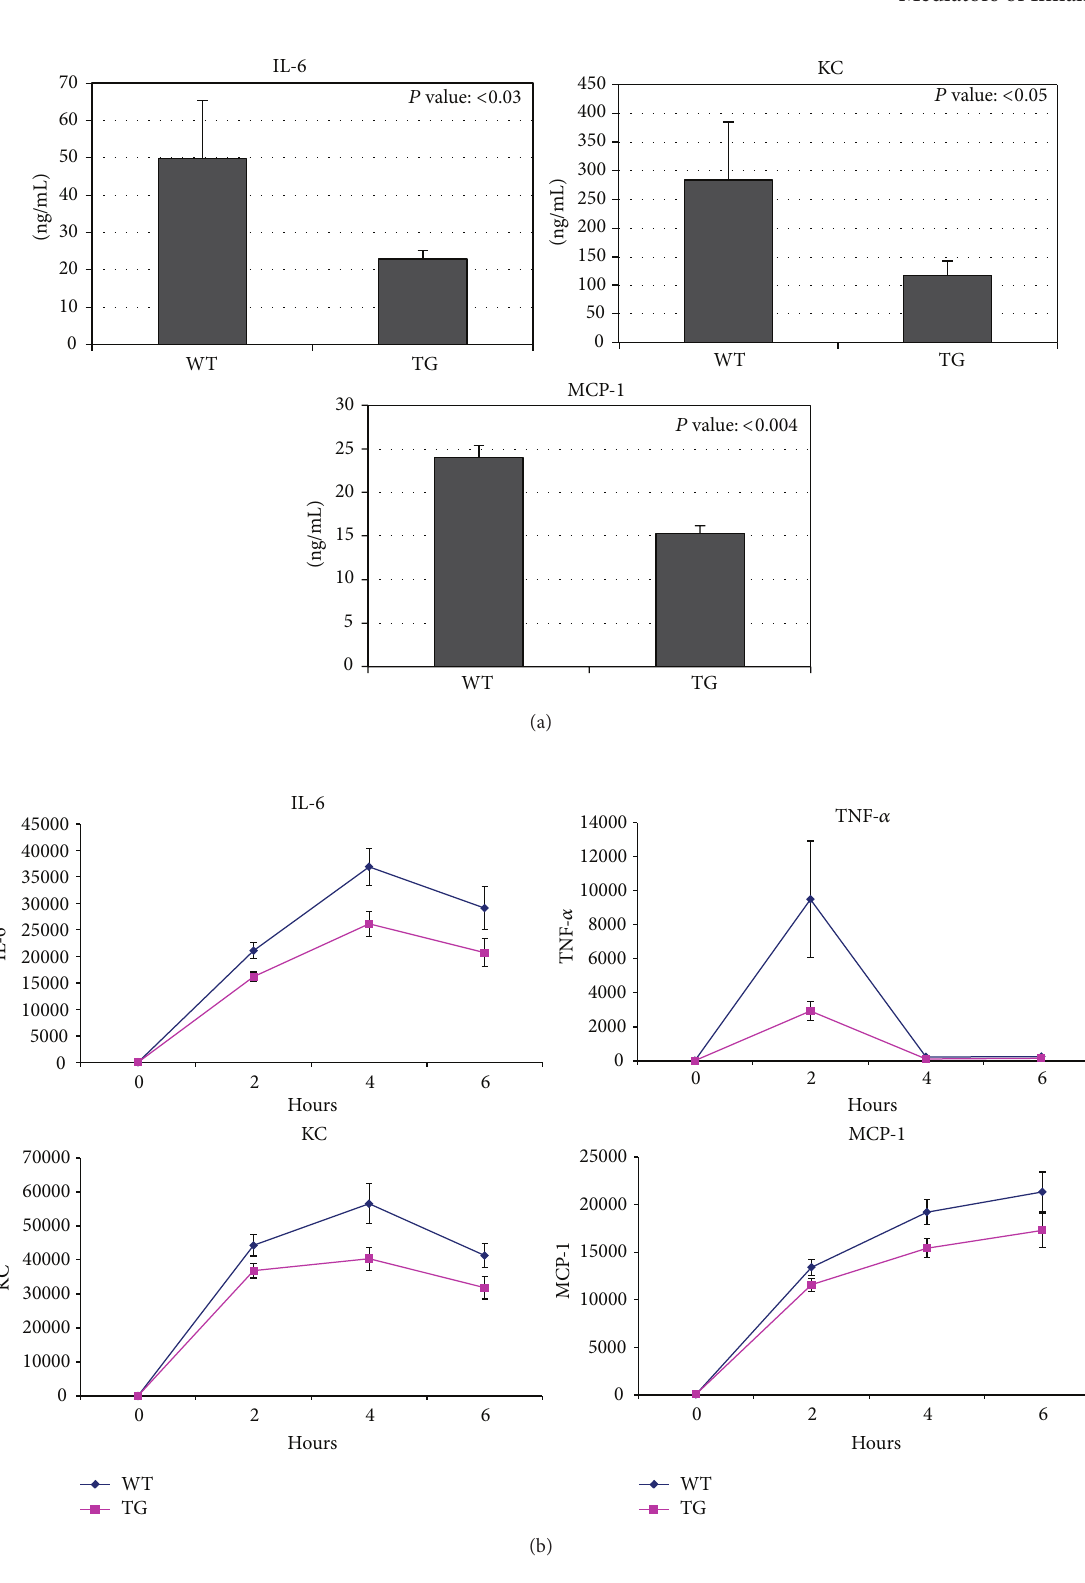
Figure1:NAG-1transgenicmicehaveadecreasedinflammatoryresponsetoLPS.Seven-totwelve-week-old 𝑁𝐴𝐺 - 1 𝑇𝑔/𝐿𝑜𝑥